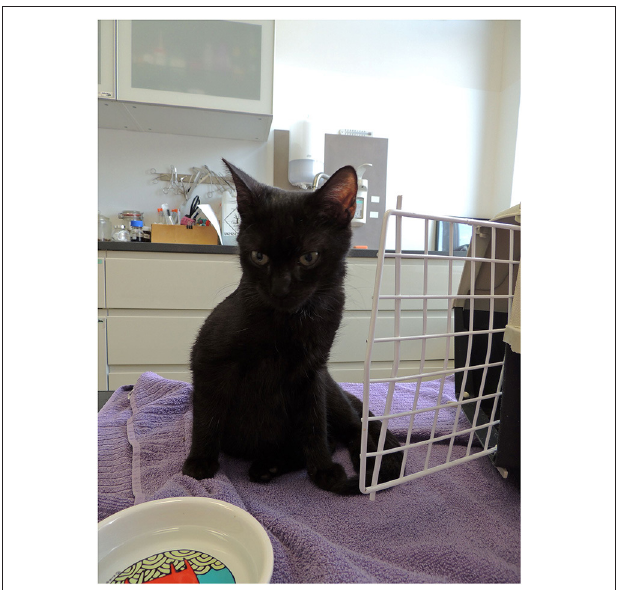
FIGURE 3 | Patient at age of 8 months, weight 2.7